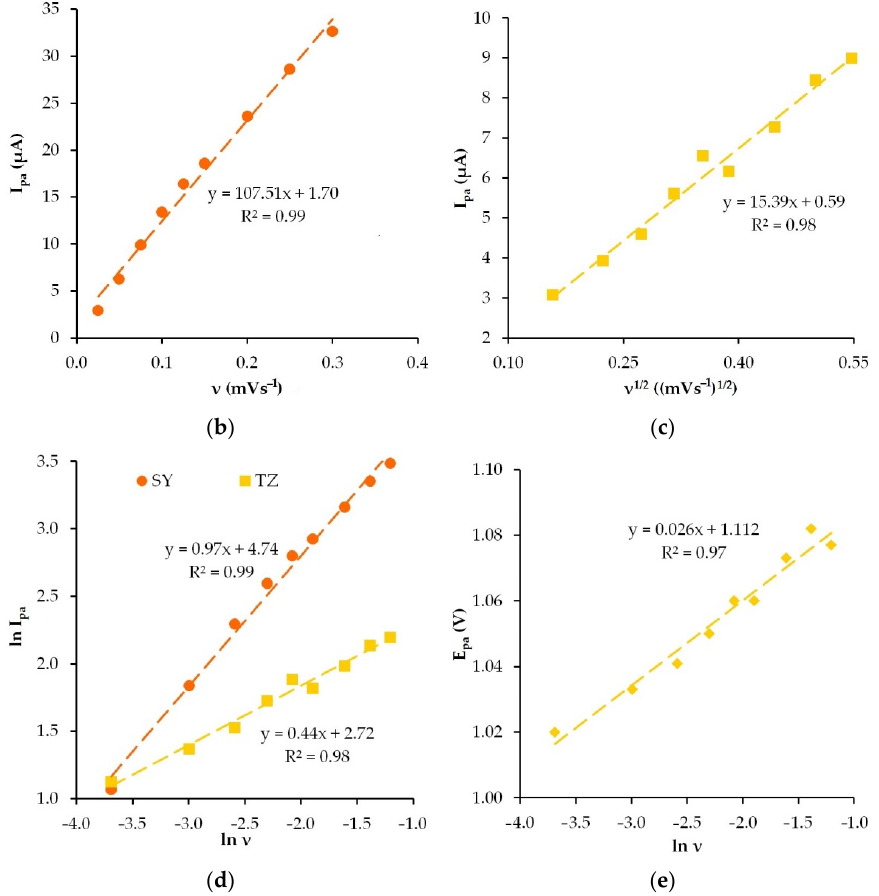
Figure 8. Linear sweep voltammograms of SY and TZ (10 µ M each) on GrP/CP electrodein phosphate buffer solution pH 5 at different potential scan rates: 25, 50, 75, 100, 125, 150, 200, 250, 300 mV s − 1 ( a ). Plots I pa = f( ν ) for SY ( b ), I pa = f( ν 1/2 ) for TZ ( c ) and ln I pa = f(ln ν ) ( d ), E pa = f(ln ν ) for TZ ( e ).